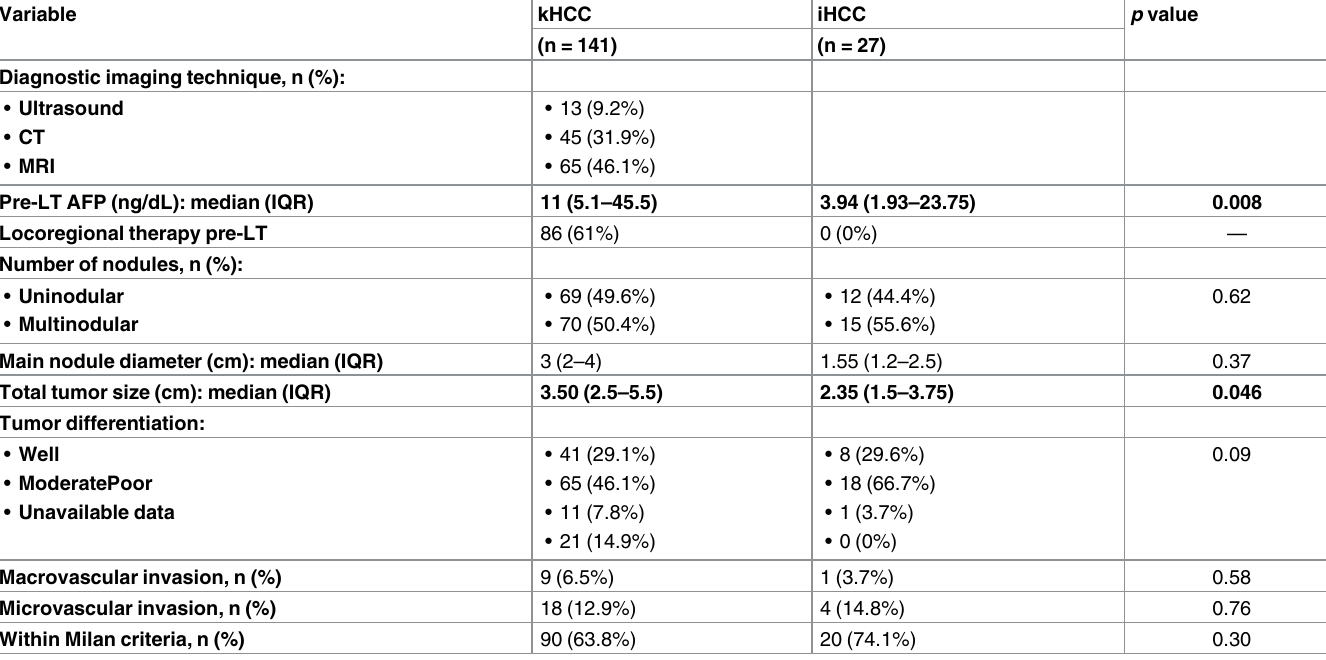
Table 2. Histological features of hepatocellullar carcinoma in the explanted liver. Patients were stratified into previouslyknown hepatocellular carci- noma (kHCC, n = 141) and incidental hepatocellular carcinoma(iHCC, n = 27). Descriptivevalues are displayedas median(interquartile range) or N (%). Sta- tistically significantfindingsare highlightedin